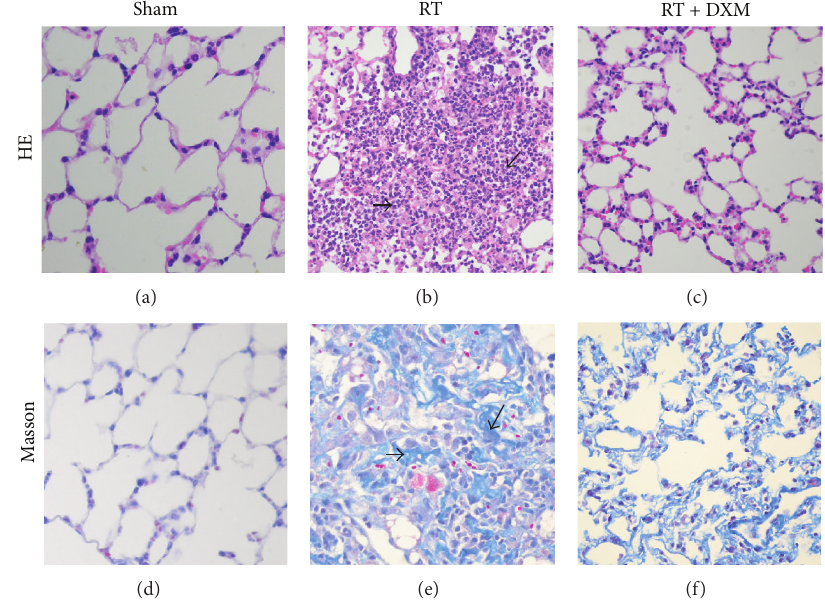
Figure 3: Representative samples of pathological changes in Sham group (a), (d), RT group (b), (e), and RT + DXM group (c), (f). Dex- amethasone attenuates radiation-induced pneumonitis and pulmonary fibrosis. Mice were administered dexamethasone (0.42mg/kg/day) intraperitoneally on days 1 to 30 after irradiation. Mice were sacrificed on specific time point, and lung tissue was fixed and excised into tissue sectionsforthedetectionofpulmonaryinflammationandcollagendepositionbyH&EorMassonstaining. In(a),(b),and(c),dexamethasone promoted the resolution of the radiation-induced pulmonary inflammation in the 4th week as indicated by H&E staining of the lung sections. (a) Sham group. (b) RT group, significant radiation pneumonitis and inflammatory cell infiltration (black arrows position). (c) RT + DXM group, inflammatory cell infiltration was significantly reduced without significant leakage. In (d), (e), and (f), dexamethasone promoted the resolution of the radiation-induced pulmonary fibrosis in the 16th week as indicated by Masson staining of the lung sections. (d) Sham group. (e) RT group, fibrosis stage, a large number of collagen depositions (black arrow position). (f) RT + DXM group, collagen deposition was significantly reduced compared with RT group; the alveolar structure is relatively